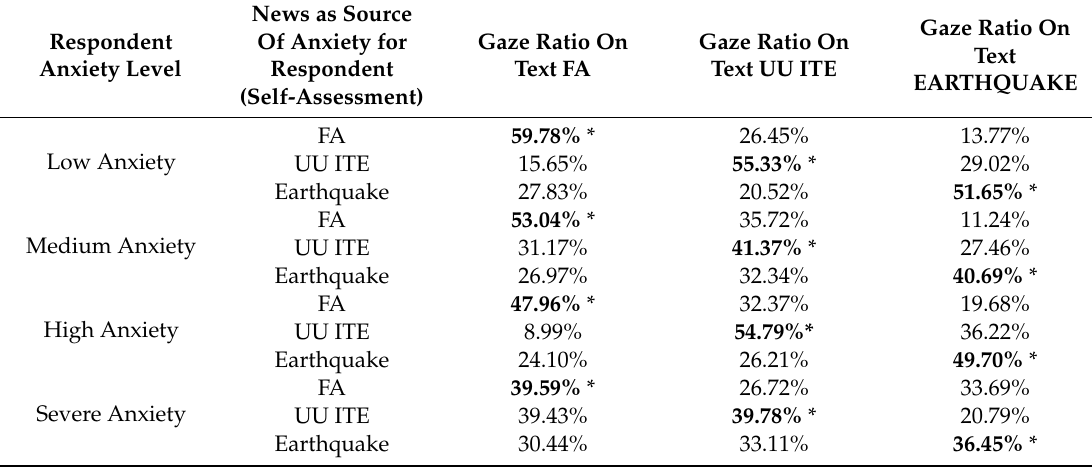
Table 27. Comparison of text gaze ratio from respondents with highest text gaze ratio on each news grouped by anxiety